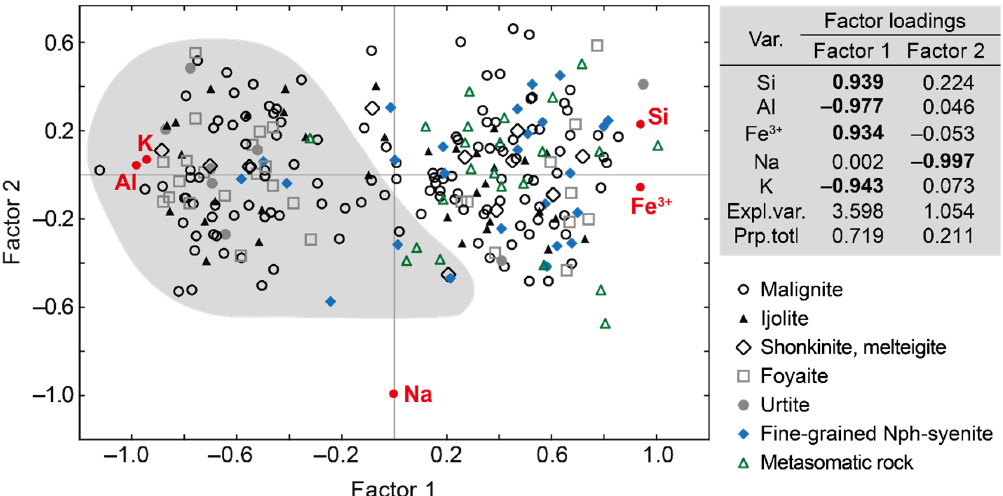
Figure 10. Results of factor analyses of data on the composition of nepheline from the Alliaiv site. Points on a gray background correspond to nepheline with inclusions of microcline and aegirine. Var.—variables; Expl.var.—Explained variance; Prp.totl—proportion of total variance. Factor loadings > |0.5| are shown in bold.